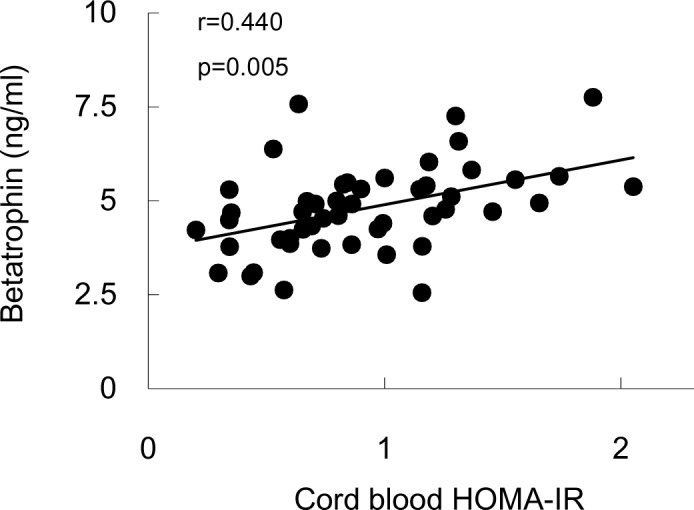
Correlation analysis between cord blood HOMA-IR and betatrophin.Correlation was adjusted for cord blood lipid profile, maternal gestational 2h post-OGTT glucose, ages, pre-pregnant BMI, prenatal BMI, gestational weight gain, offspring parity, sex, birth weight and gestational age at delivery. Data represents both cohorts (n = 54).